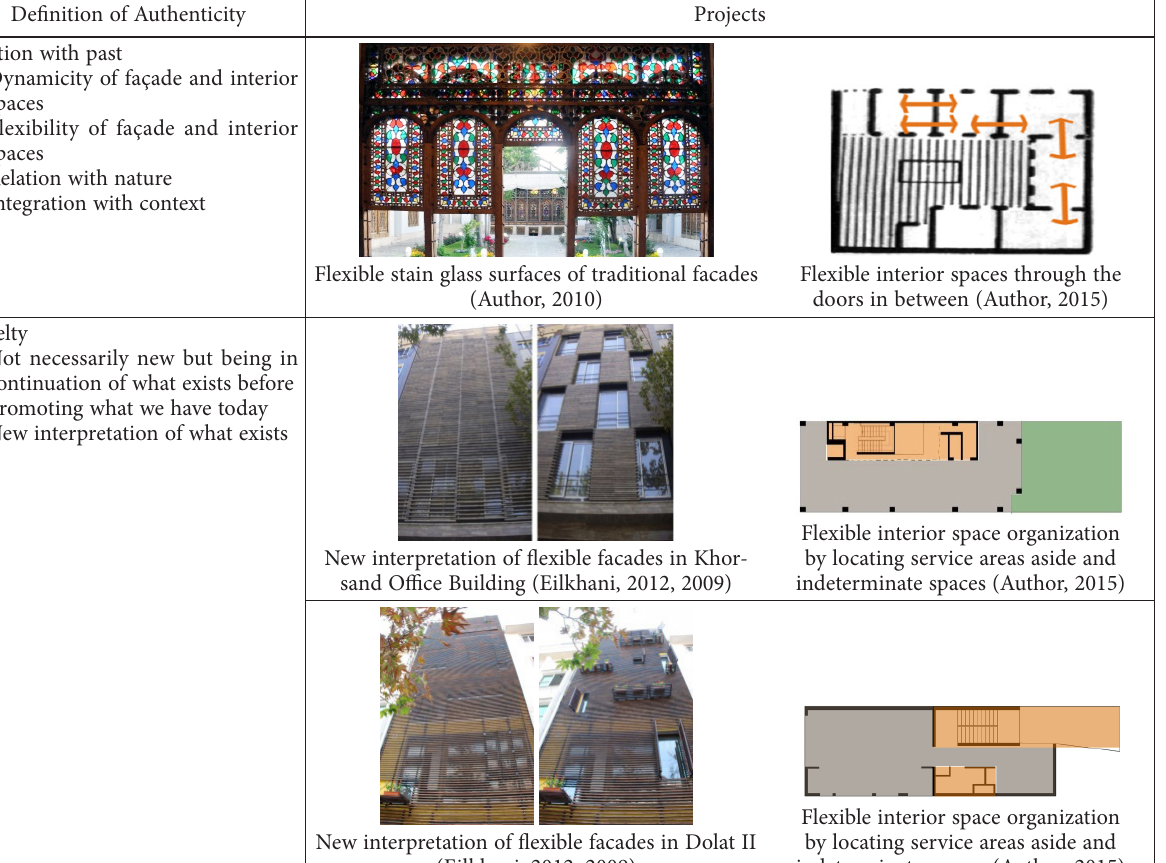
Table 3. Dynamicity and flexibility of interior spaces and facades as an authentic feature in Rambod Eilkhani’s projects Definition of